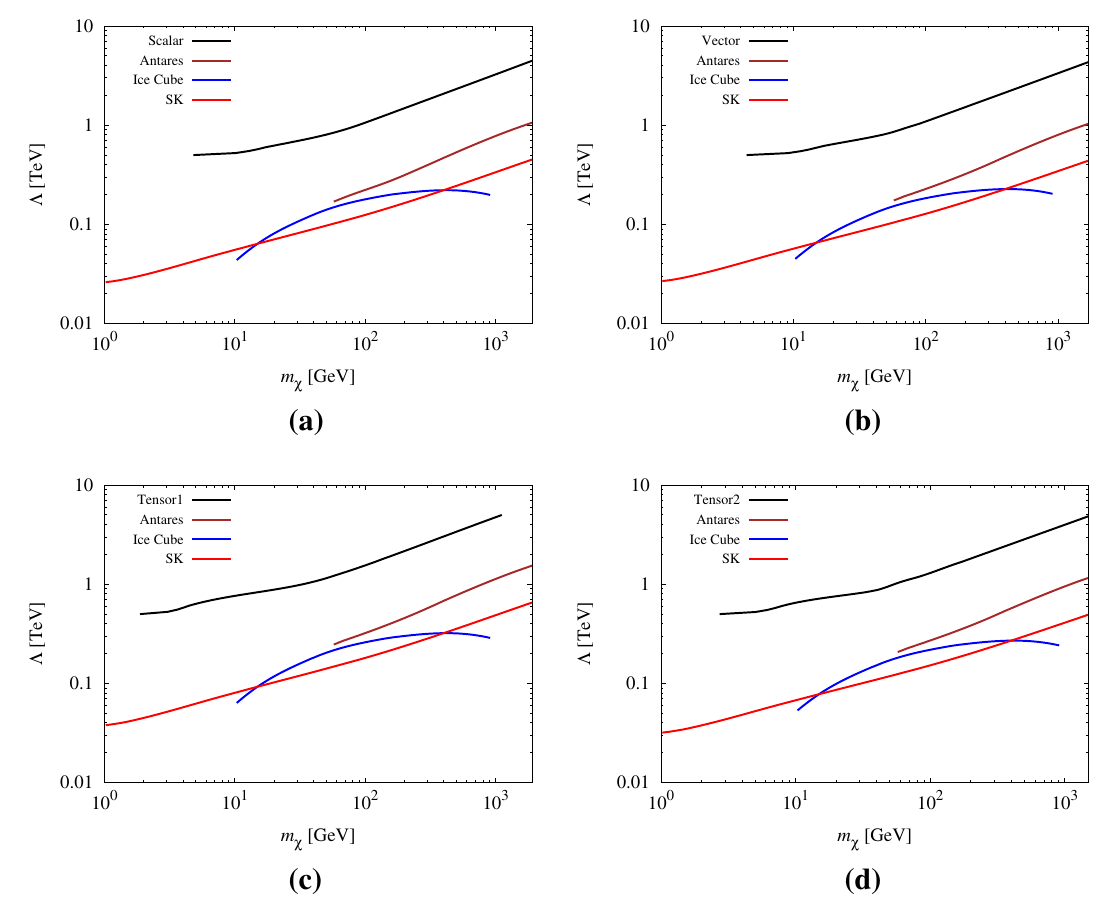
spin- 3 DM, χ μ , saturates the observed relic density Ω DM h 2 (cid:6) 0 . 12. 2 The brown, blue and red solid lines show the constraints from Antares, Ice Cube and SK experiments.